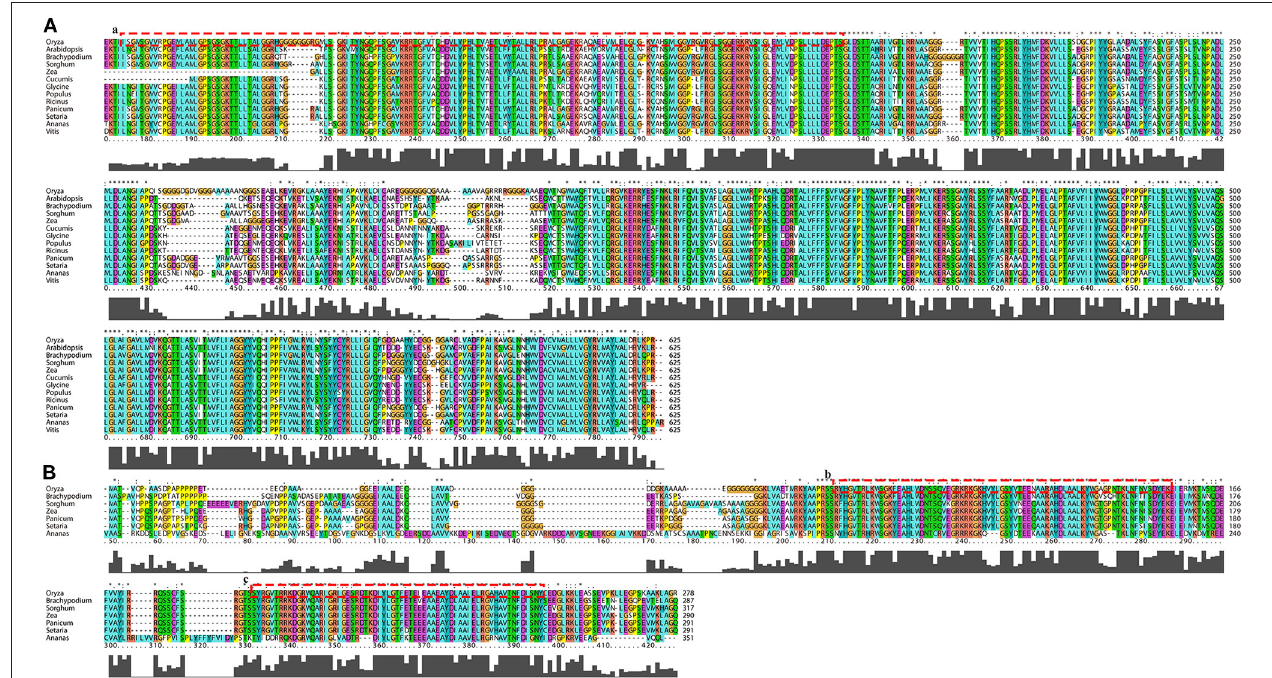
FIGURE 6 | The amino acid sequence alignments of LOC_Os08g07010 (A) and LOC_Os08g07440 (B) homologs from different species. Amino acids marked with the same color in each column indicate 100% sequence identity. Gray columns with different heights represent the similarity of each amino acid sequence from different species. a, b, and c (the amino acid sequence inside the red dashed box) represent the conserved domains in LOC_Os08g07010 and LOC_Os08g07440